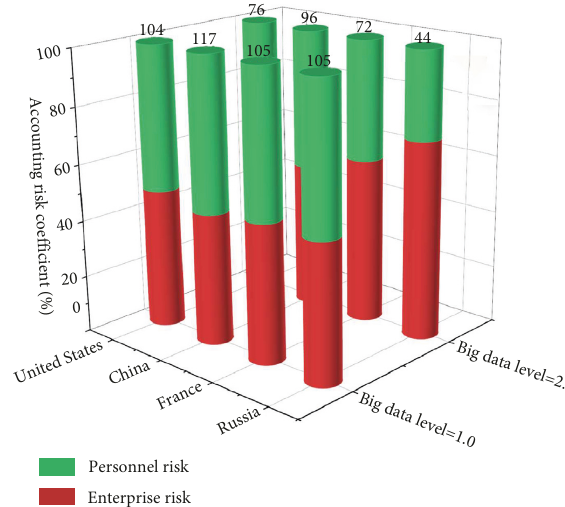
Figure 5: Relationship curve between risk awareness and ac- counting meaning ratio under different big